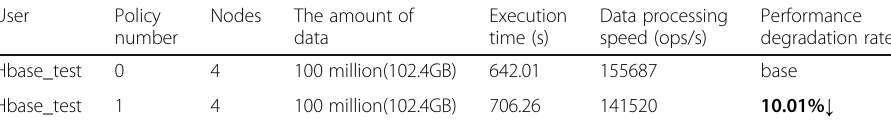
Table 3 Current access control function test results based on the User-Resource-Rights policy